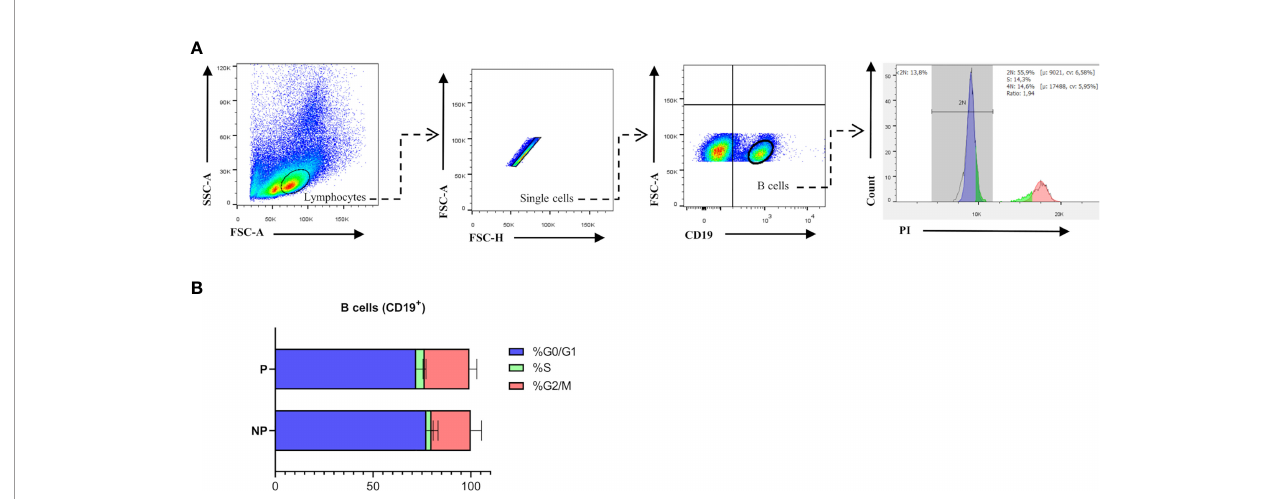
FIGURE 2 | (A) . Cell Cycle gating strategy for B cell analysis by fl ow cytometry. Representative pseudocolor and contour plots showing gating strategy used to quantify percentages of cell cycle phases in B cells from spleens of pregnant (n=5) and non-pregnant (n=5) mice. Lymphocytes were gated by forward scatter (FSC) vs. side scatter (SCC), doublets were eliminated and CD19 was used to de fi ne the total B cell population in the spleen. Over gated B cells (CD19 + ), a representative histogram of propidium iodide (PI) staining was used to evaluate phase G0/G1 in (blue), phase S (green), and phase G2/M (red). Auto- fl uorescence of each biological replicate was used as negative control for CD19. (B) . Comparison of B cell cycle analysis in pregnant and non-pregnant mice. Bar plots show a tendency of arrest in the S and G2 phase of B cells (CD19 + ) from pregnant (P) (G0/G: 72.8±6; S: 4.4±0.5; G2/M: 22.8±3.7; n=5) compared to non-pregnant (NP) (G0/G:77.3±3.5; S:2.6±